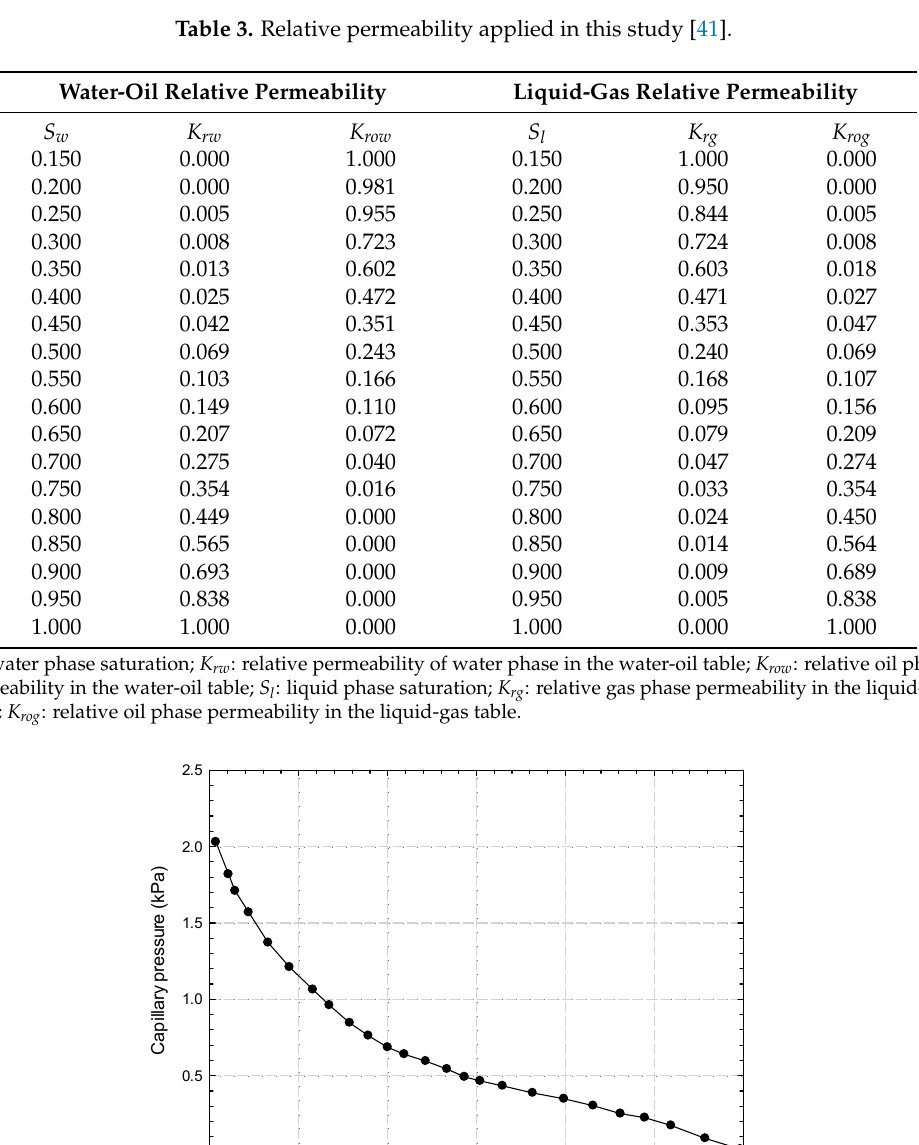
Table 3. Relative permeability applied in this study [41].